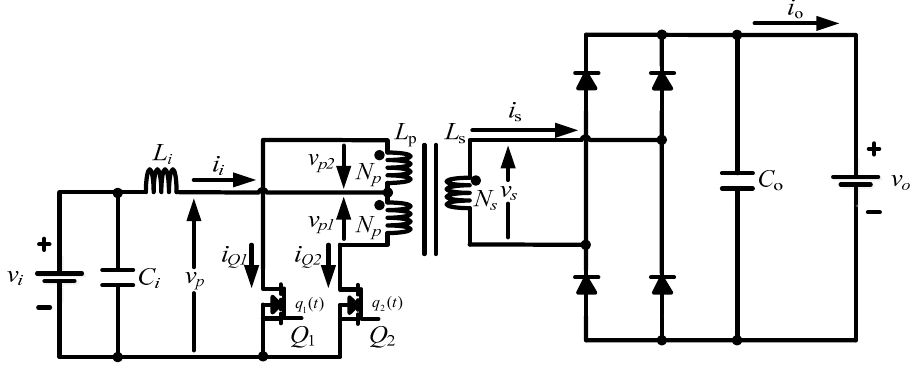
Figure 4. Configuration of a current-fed push-pull converter.